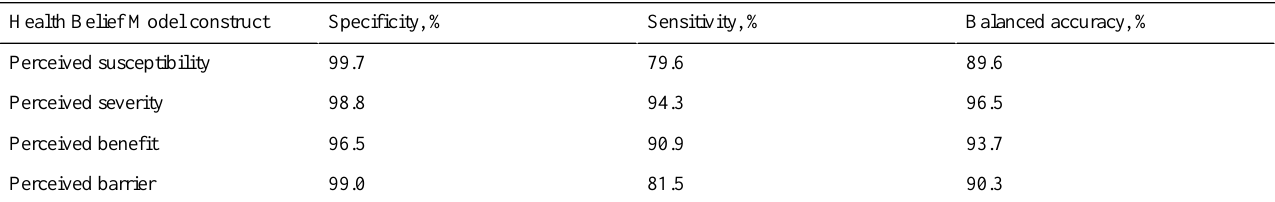
Table 3. Performance of the Health Belief Model classification models with MOH Facebook comments.